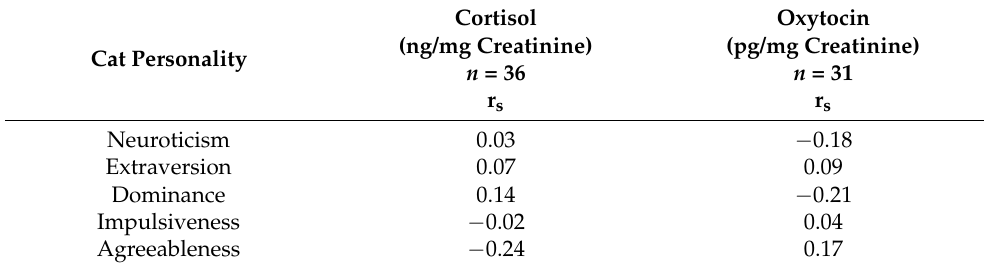
Table 3. Correlation between hormone levels and cat personality.